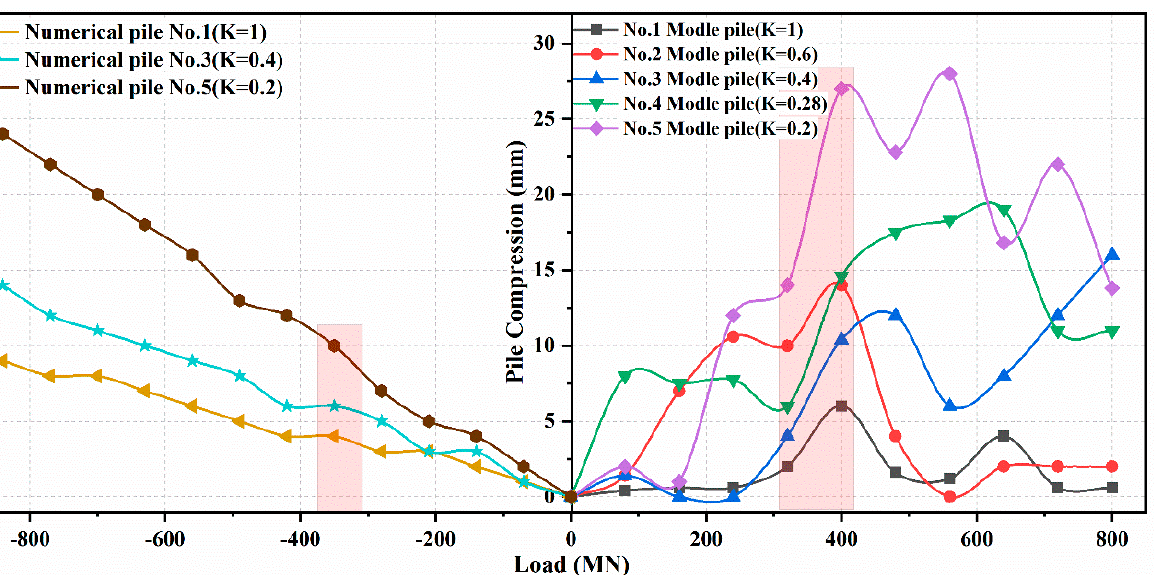
Figure 18. Comparison of pile compression.